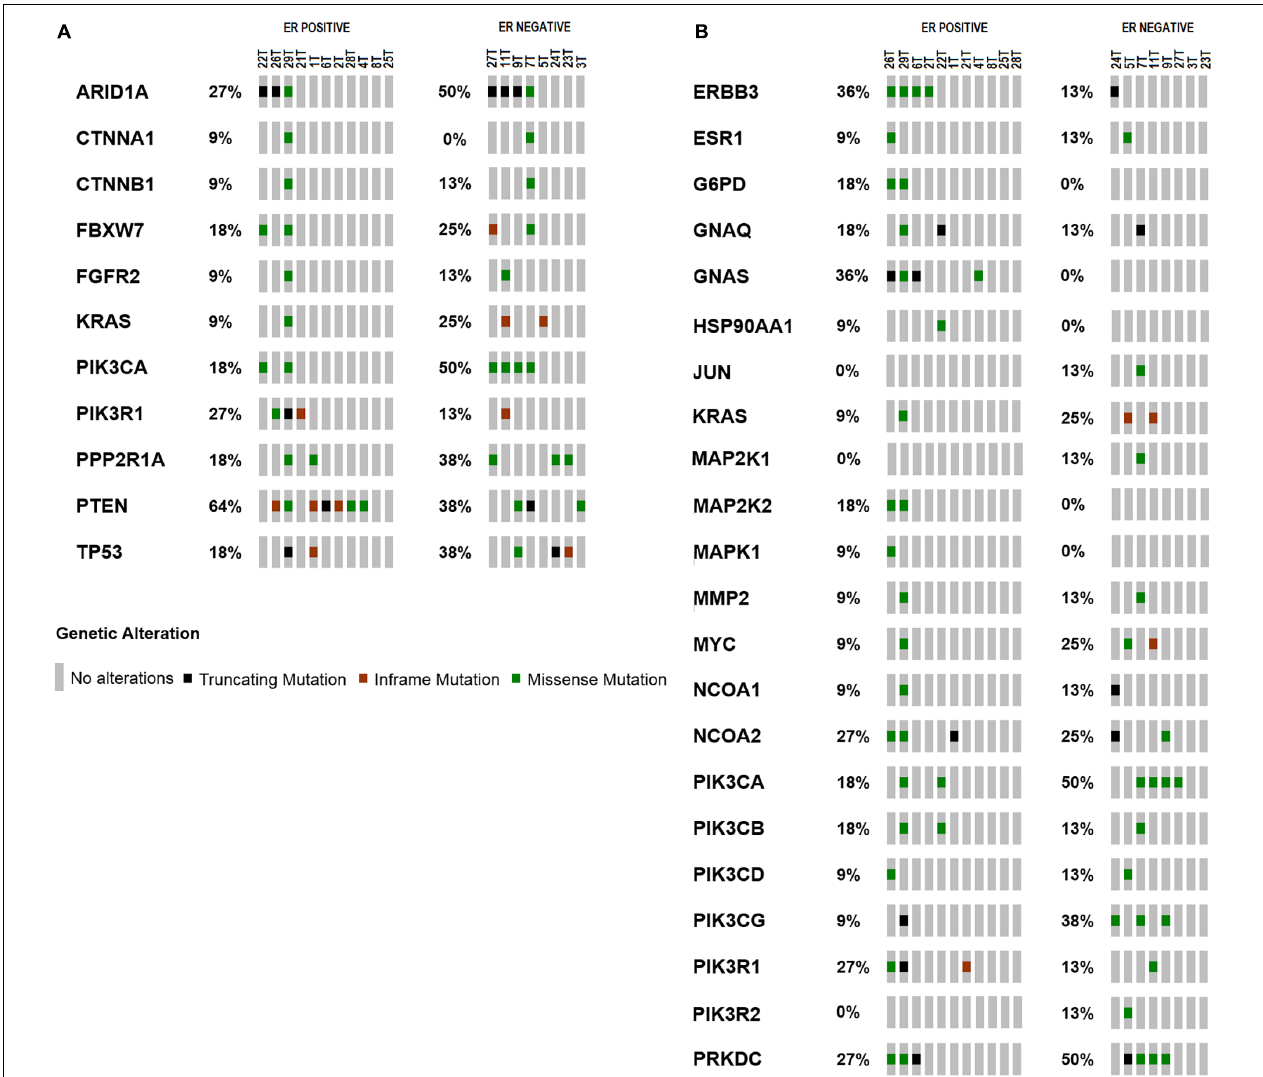
FIGURE 2 | Frequency of mutations in (A) genes related in carcinogenesis of EEC. PTEN is the most frequently altered gene in ER positive subtype (64%, n = 11); ARID1A is the most frequently altered gene in ER negative group (63%, n = 8). (B) Frequency of mutations in genes relevant to ER signaling pathway compiled from literatures. ERBB3 and GNAS are the most frequently altered genes in ER positive subtype (36%, n = 11); PIK3CA is the most frequently altered gene in ER negative group (50%, n =